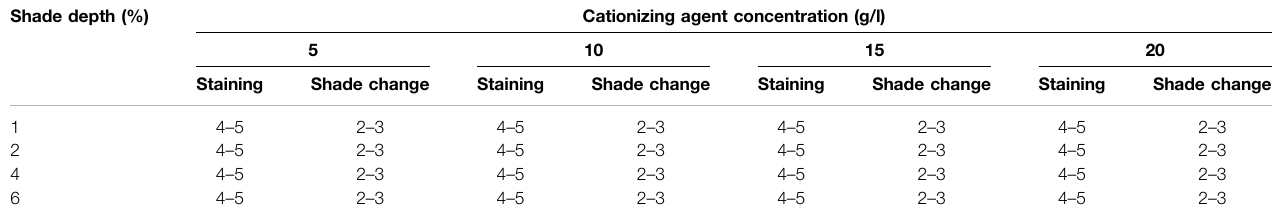
TABLE 4 | Colorfastness to perspiration results recorded according to the ISO 105 E04:2013 standard protocol for cationized cotton dyed samples. Shade depth (%)